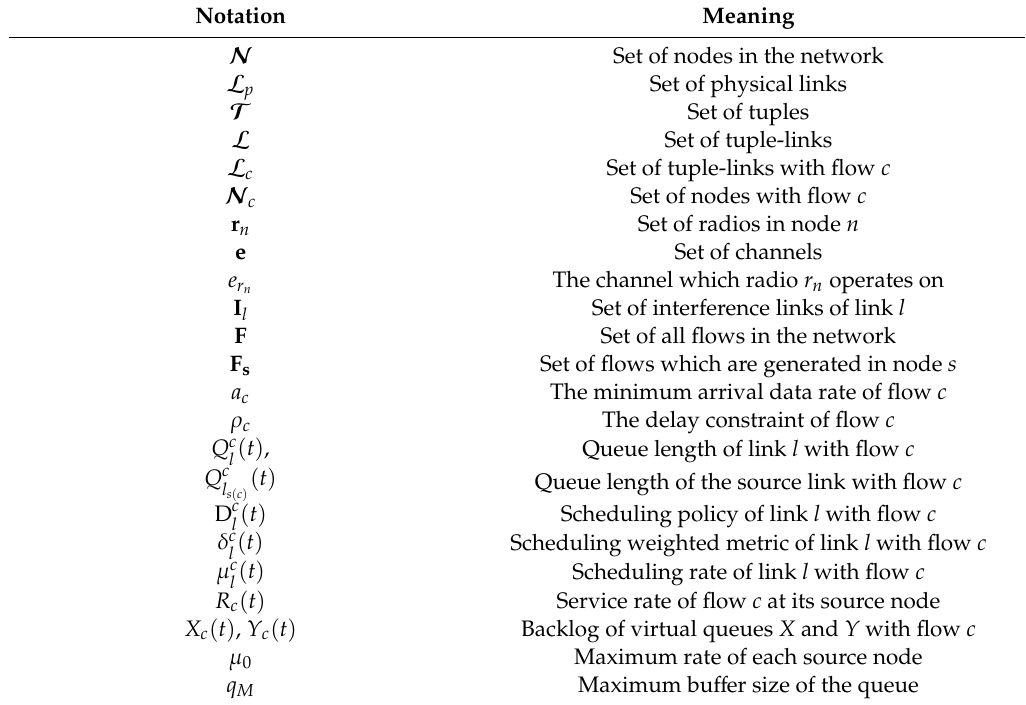
Table 1. Summary of key